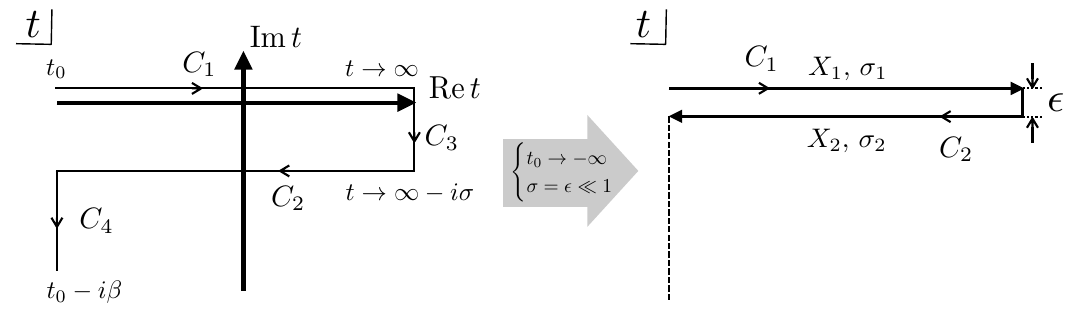
Figure 3 . Starting from the general closed-time-path (CTP) contour C for the initially thermalized system (left (cid:12)gure), we choose the limit (right (cid:12)gure) in which the initial time is taken as the past in(cid:12)nity ( t 0 ) and the forward and backward paths are laid to overlap each other ( (cid:27) = (cid:15) ! (cid:0)1 In this limit, we only need to consider the Green function between the variables on the forward